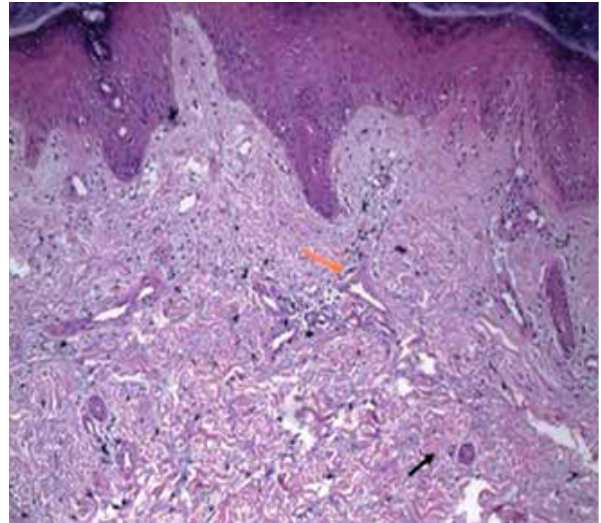
Fig 7. Biopsy shows moderately dense superficial and mid–perivascular lymphocytic infiltrate (red arrow) with abundant mucin in reticular dermis (black